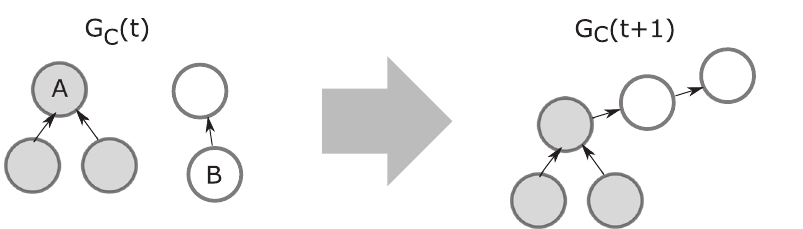
Fig 5. Example of a one-step transition in the network formation process. At some time t � 0, we have an emergent network G ( t ) with its condensation graph G C ( t ). Assume the pair of agents ( i , j ) is chosen at time t by the network formation process, with i such that Γ ( i , G ( t )) corresponds to node A and j such that Γ ( j , G ( t )) corresponds to node B in G C ( t ). Then G C ( t + 1), which is the condensation graph of G ( t + 1), is as shown in the figure for non-consensual agents, and for consensual agents if and only if H (2) − H (0) � c